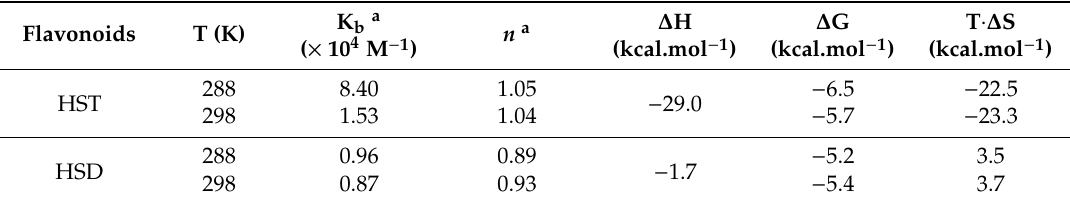
Table 1. Binding constant (K b ), number of binding sites ( n ), enthalpy change ( ∆ H), Gibbs free energy change ( ∆ G), and entropy change ( ∆ S) of the M 2-1 / flavonoid interaction determined using fluorescence quenching experiments at 288 and 298